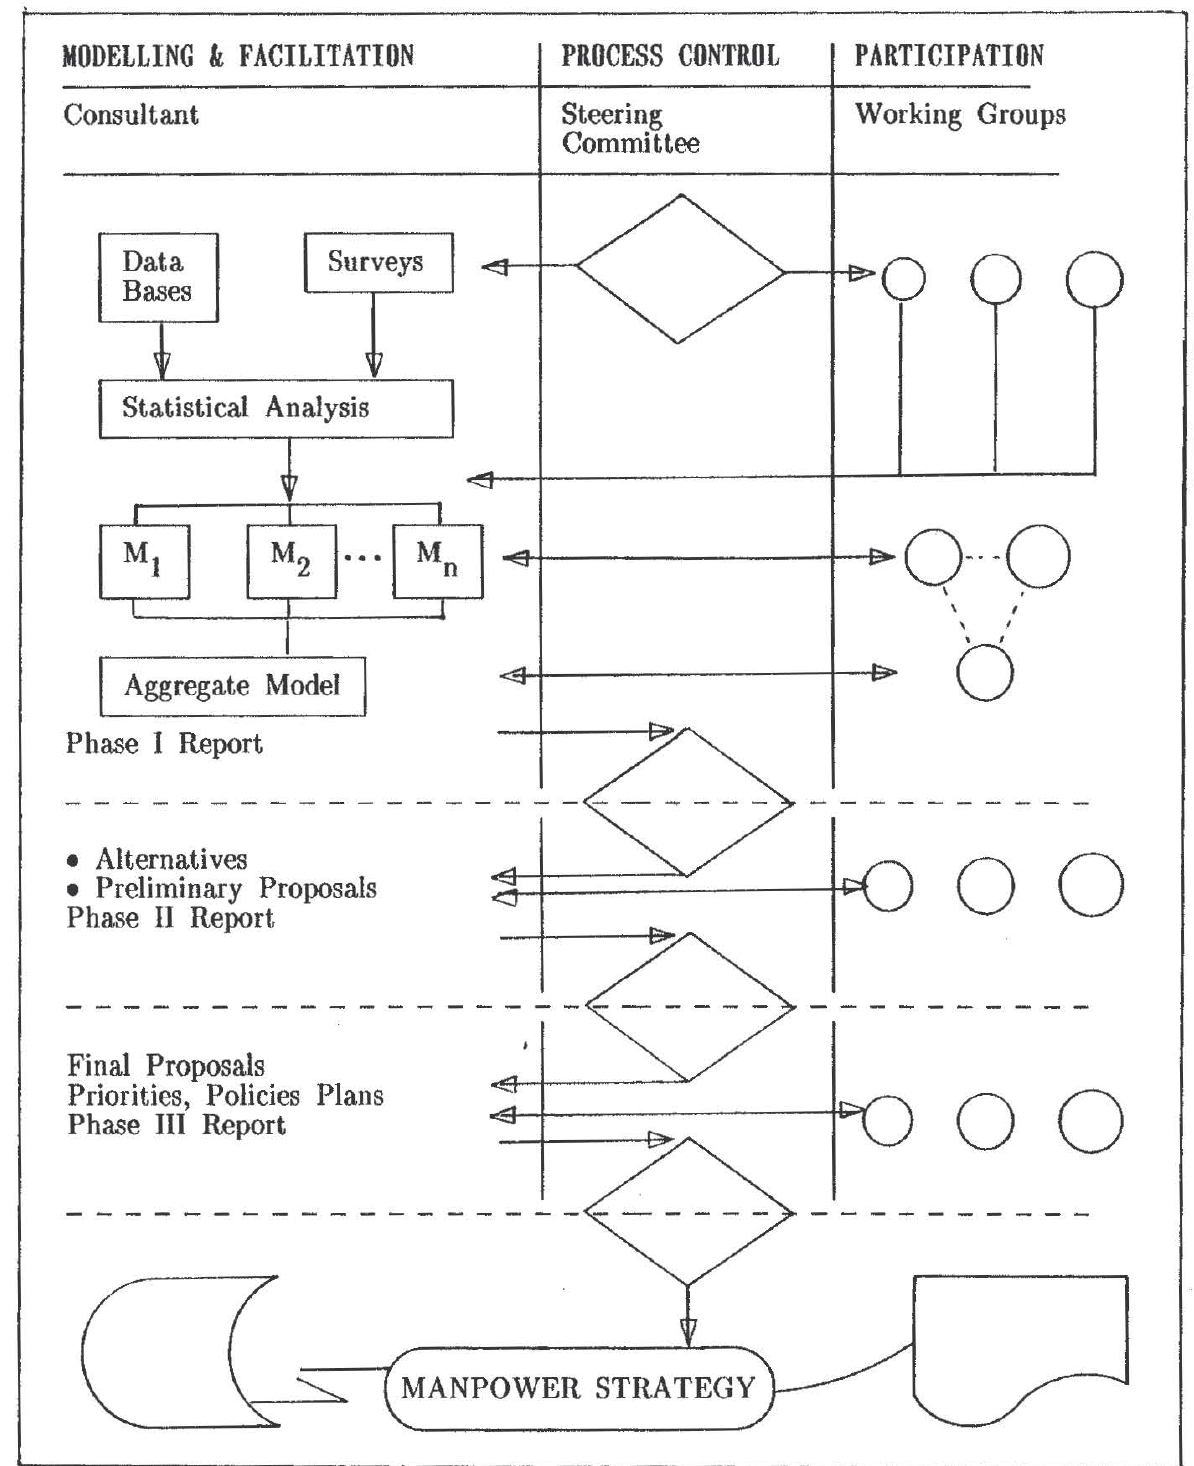
Figure 2. The Process for Manpower